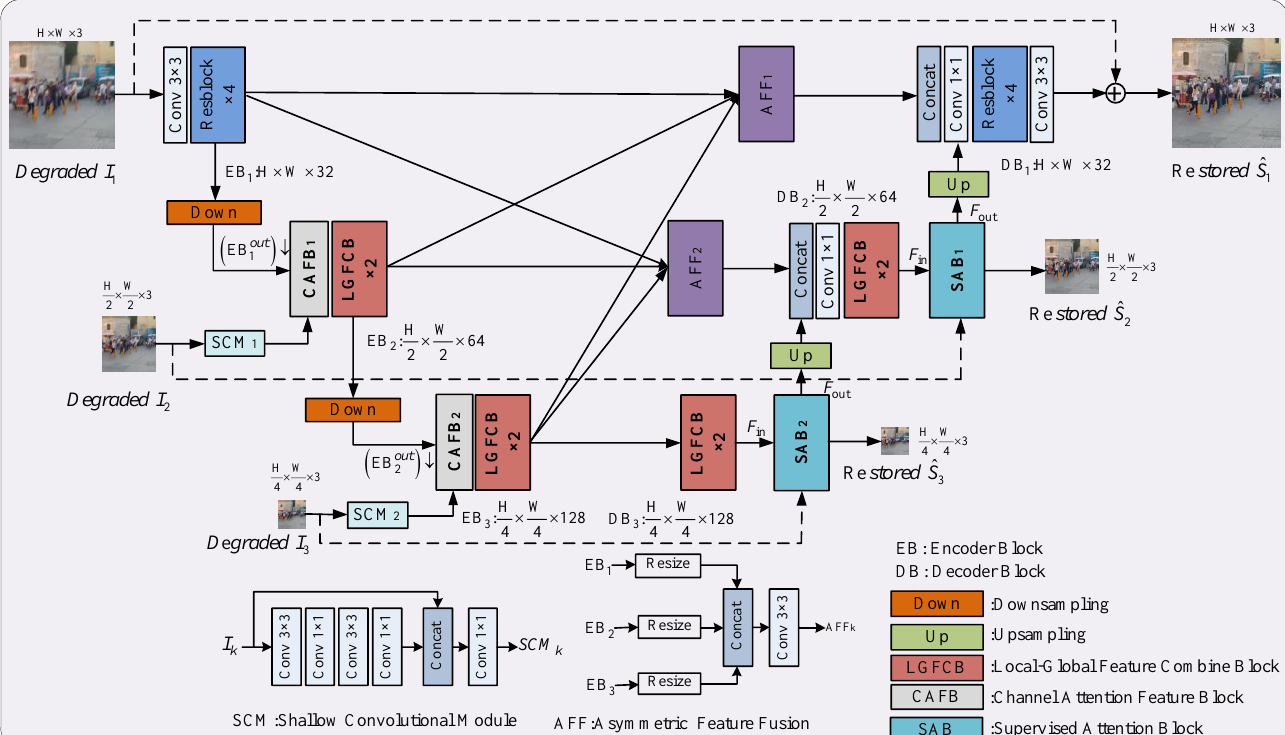
Figure 1. The whole structure of the proposed deblurring network.